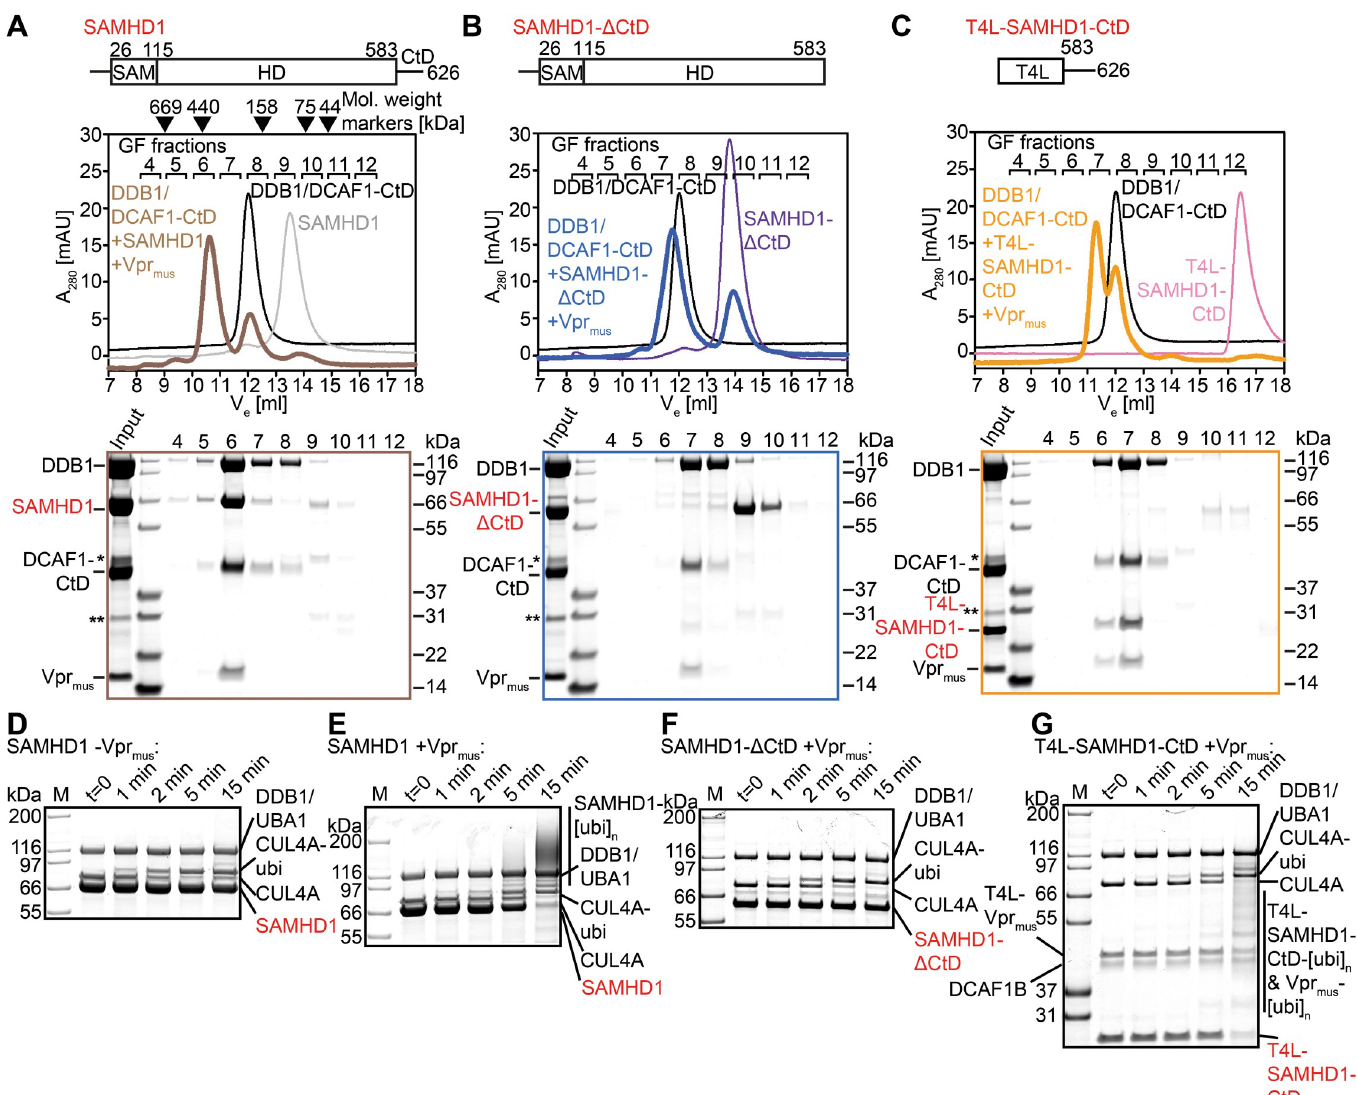
Fig 1. Biochemical analysis of Vpr mus -induced CRL4 DCAF1 specificity redirection. ( A-C ) GF analysis of in vitro reconstitution of protein complexes containing DDB1/ DCAF1-CtD, Vpr mus and SAMHD1 ( A ), SAMHD1- Δ CtD ( B ) or T4L-SAMHD1-CtD ( C ). Elution volumes of protein molecular weight standards are indicated above the chromatogram in A . Coomassie blue-stained SDS-PAGE analyses of fractions collected during the GF runs are shown below the chromatograms, with boxes colour-coded with respect to the chromatograms. SAM–sterile α -motif domain, HD–histidine-aspartate domain, T4L –T4 Lysozyme. The asterisk and double asterisk indicate slight contaminations with remaining GST-3C protease and the GST purification tag, respectively. ( D-G ) In vitro ubiquitylation reactions with purified protein components in the absence ( D ) or presence ( E-G ) of Vpr mus , with the indicated SAMHD1 constructs as substrate. Reactions were stopped after the indicated times, separated on SDS-PAGE and visualised by Coomassie blue staining.